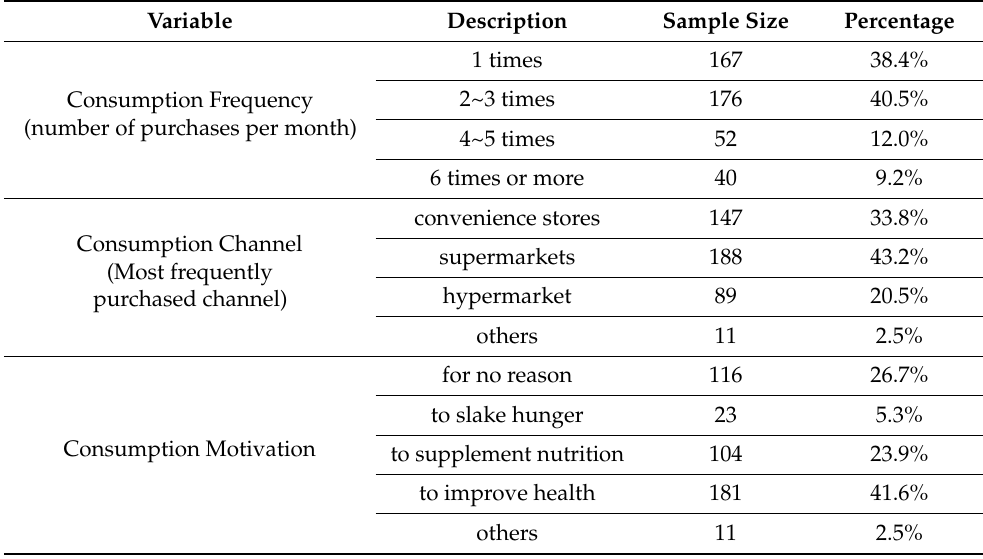
Table 4. Respondents’ experiences in purchasing